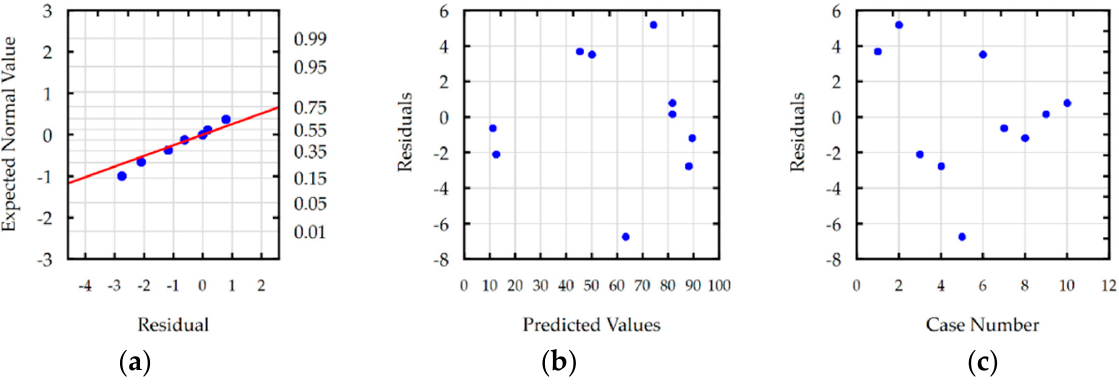
Figure 10. Plots for the model of MRR: ( a ) the normal plot of residuals; ( b ) the residuals versus the predicted values; and ( c ) the residuals versus the case number.